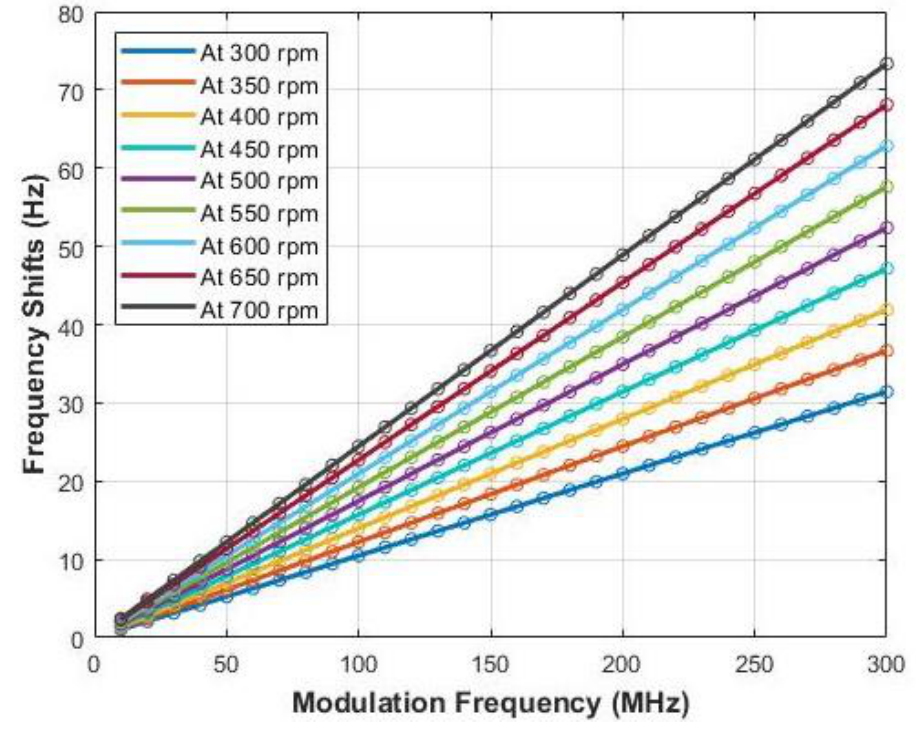
Figure 11. Theoretical (expected) frequency shifts at different